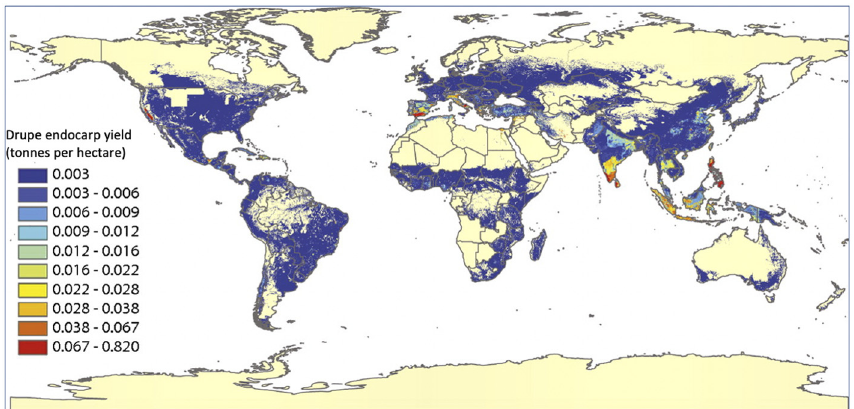
Figure 11. Bioenergy potential in the world [27] .